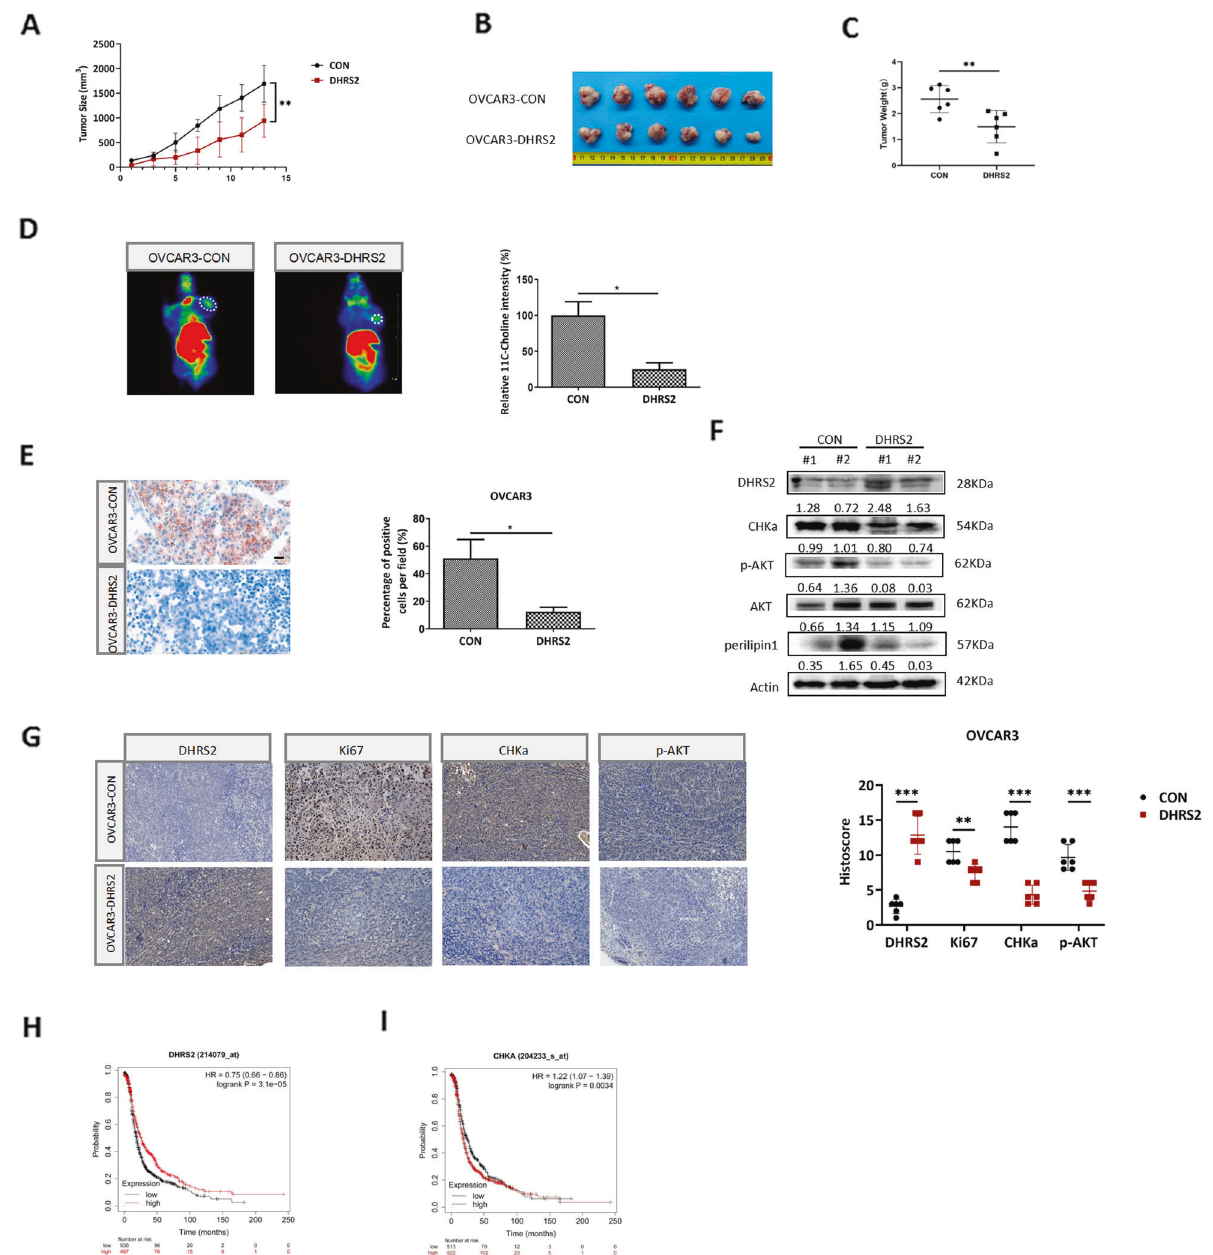
Fig. 5 DHRS2 impairs tumor growth in vivo by interfering with the CHK α -AKT axis and choline metabolism. A The growth curve of OVCAR3-CON and OVCAR3-DHRS2 cells in vivo. Female BALB/c nu/nu mice were subcutaneously inoculated with OVCAR3-CON and OVCAR3- DHRS2 cells ( n = 6 per group). Tumor volume was examined every other day and shown in the graph. B At the end of the experiment, the mice were sacri fi ced and the tumors were separated. C Tumor mass of each group was measured and shown in the graph. D 11 C-Choline micro-PET/CT was performed and standardized uptake value (SUV) intensity was observed in the designated groups. E Representative images of Oil Red O staining in tumor tissues of the designated group. F The protein levels of DHRS2, CHK α , p-AKT, AKT, and perilipin1 in tumor tissues of the designated group. G Representative images of tumor sections in each group stained with indicated antibodies. Antibody staining is in brown and nuclear counter staining is in blue. Scatter diagram shows Histoscore for the indicated antibody staining in tumor samples. Survival analysis from TCGA dataset assessed by the Kaplan – Meier method for OC patients with high or low signature of H DHRS2 and I CHK α genes. Data are shown as mean values ± S.D. of independent, triplicate experiments. The asterisks (*,**,***) indicate signi fi cant differences ( p < 0.05, p < 0.01, p < 0.001, DHRS2 impairs tumor growth in vivo by the interfering with association with the overall survival of OC patients ( p < 0.01, Fig. CHK α -AKT axis and choline metabolism. 5I). The expression of DHRS2 showed a negative association with that of CHK α , and CHK α expression positively correlated with perilipin1 ( p < 0.05; Supplementary Fig. 4). Moreover, DHRS2 hampers the invasion and metastasis of OC in vivo DHRS2 expression inversely correlated to AKT signaling We have demonstrated that DHRS2 inhibits the invasive capacity ( p < 0.05; Supplementary Fig. 4). Overall, our data support that of OC cells in vitro. A 3D Matrigel cell culture model was further